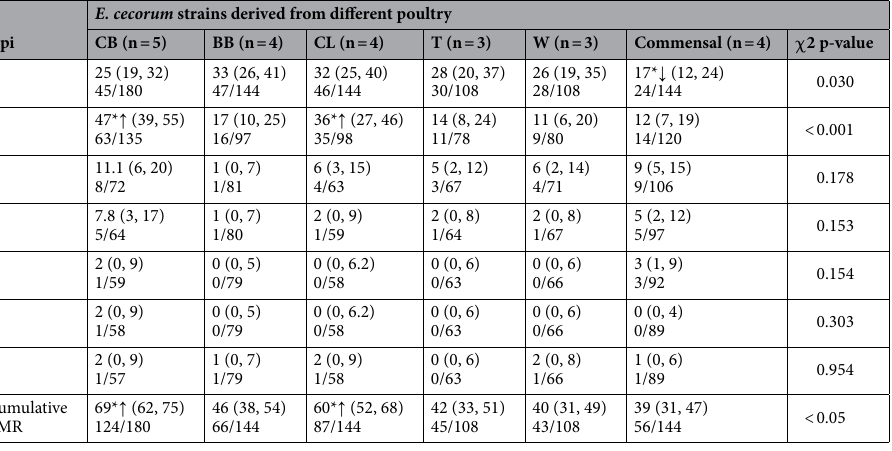
Table 2. Summary of embryo mortality by day caused by clinical (CB, BB, CL, T, W) and commensal Enterococcus cecorum strains. Results are presented as % mortality (with 95% CI) and the number of deaths / number of surviving embryos. Cumulative EMR is showed as % mortality (with 95% CI) and the number of deaths / total number of inoculated embryos. Dpi – days post-infection. EMR – embryo mortality rate. P-values apply to the comparison of groups indicated by asterisk (*) with other groups using a chi-square test. Asterisks (*) show statistically significant differences between values in the row. Arrow shows that the value is significantly higher ( ↑ ) or lower ( ↓ ).